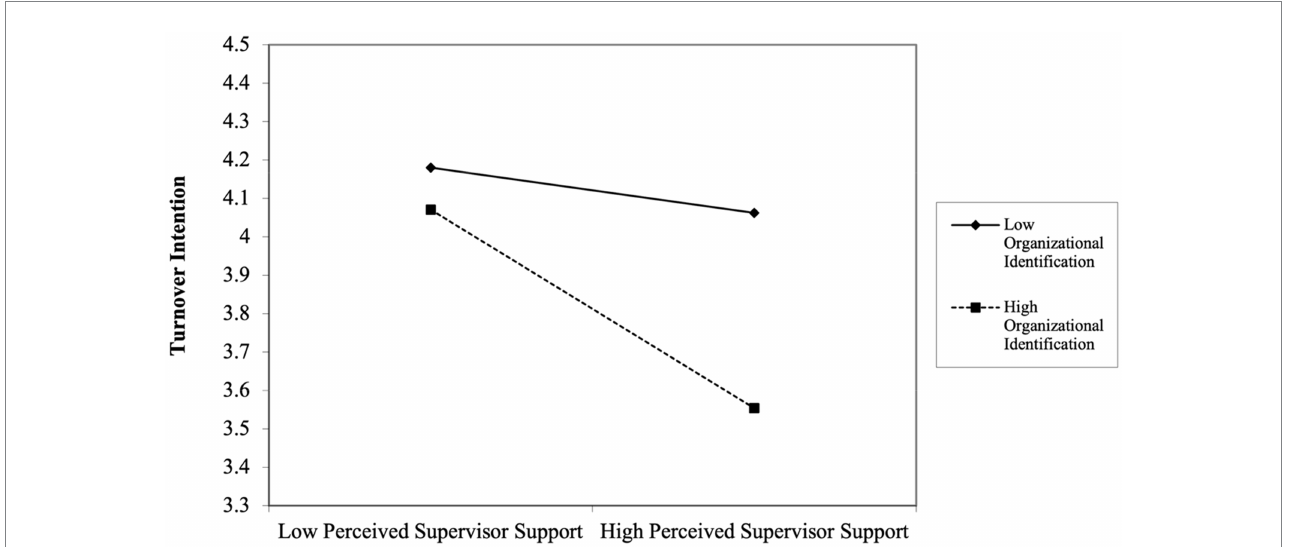
FIGURE 2 Interaction effect of organizational identification.